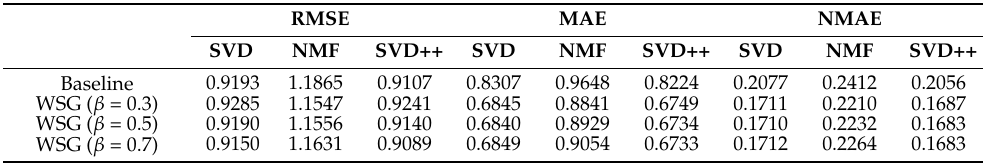
Table 5. RMSE, MAE, and NMAE values with and without L-CNN sentiment and genres-based model and different values of β on the MARD dataset. Table 6. RMSE, MAE, and NMAE values with and without C-LSTM sentiment and genres-based model and different values of β on the MARD